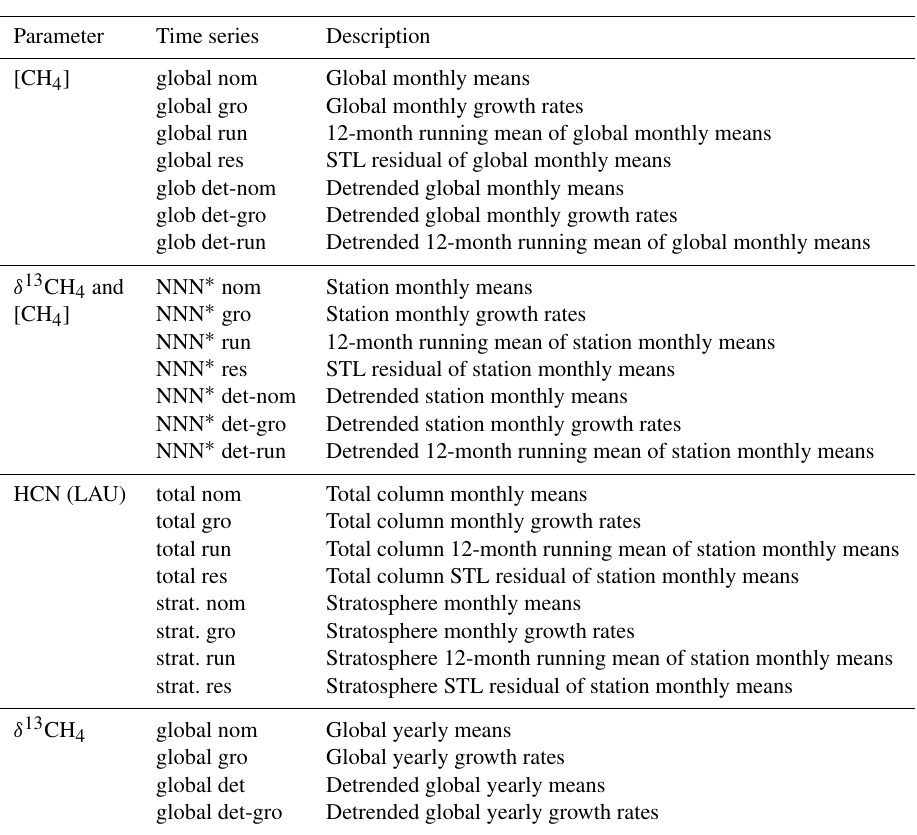
Table 1. Description of time series products used in the correlation analyses. Parameter Time series